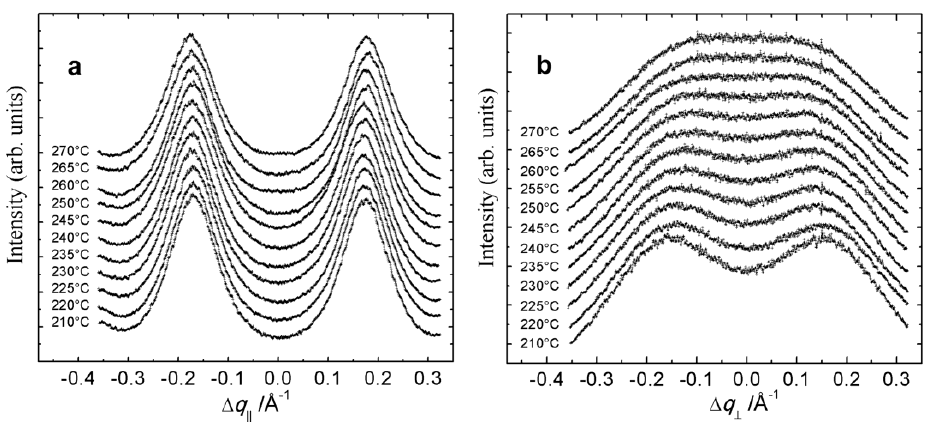
Figure 3. Intensity profiles ( a ) I ( ∆ q (cid:107) ) and ( b ) I ( ∆ q ⊥ ) of the low-angle di ff use spots measured through the maxima at q 0 along the longitudinal ( (cid:107) B ) and transverse ( ⊥ B ) directions, respectively, at di ff erent temperatures in the skewed cybotactic N phase of BCM 1a . Reproduced from [14] with permission from The Royal Society of Chemistry.